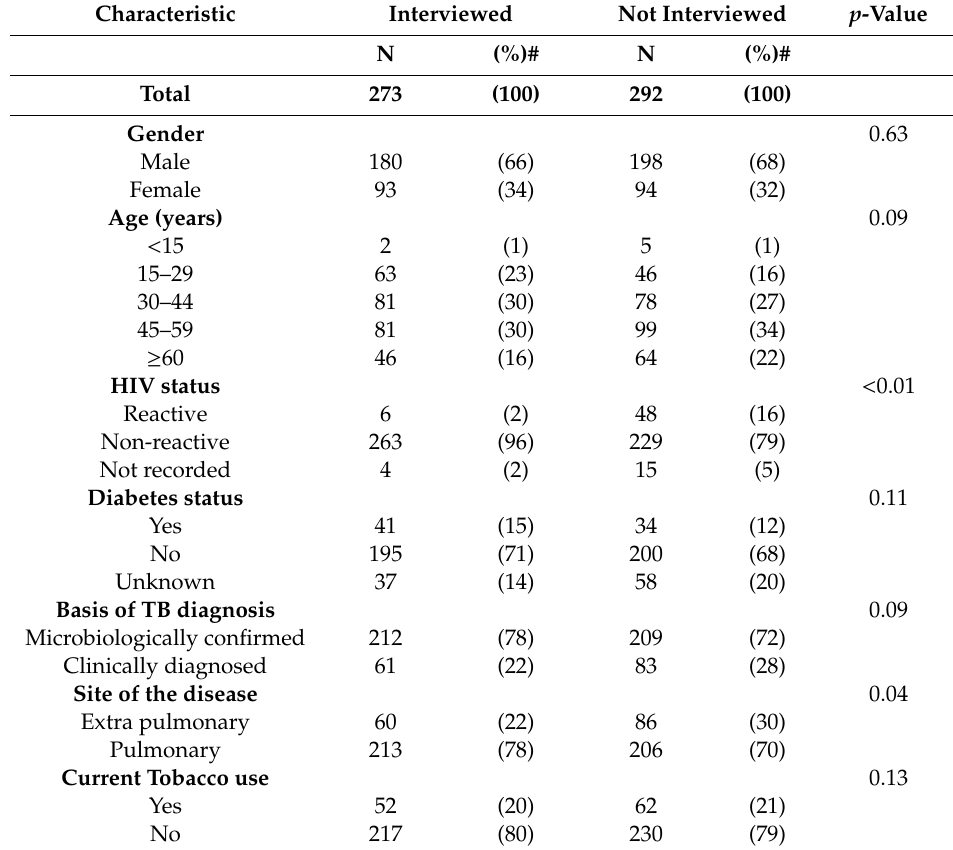
Table 1. Comparison of clinical and demographic characteristics of new tuberculosis (TB) patients started on treatment at Udupi district, Karnataka, India, from October 2018 to June 2019 who were interviewed and not